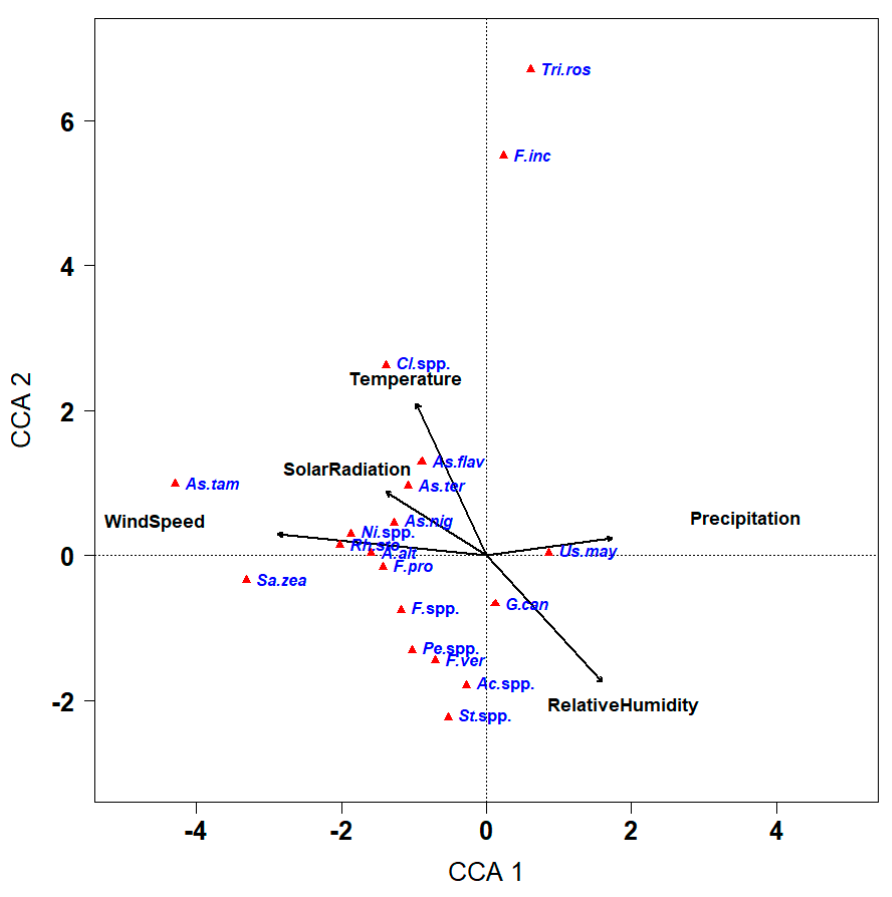
Figure 9. Ordination diagram of canonical correspondence analysis of seed-borne mycoflora in maize grain samples collected from 25 maize-growing governorates with five weather variables. The red triangles denote the fungal pathogens and line arrows denote the weather variables. Ac.